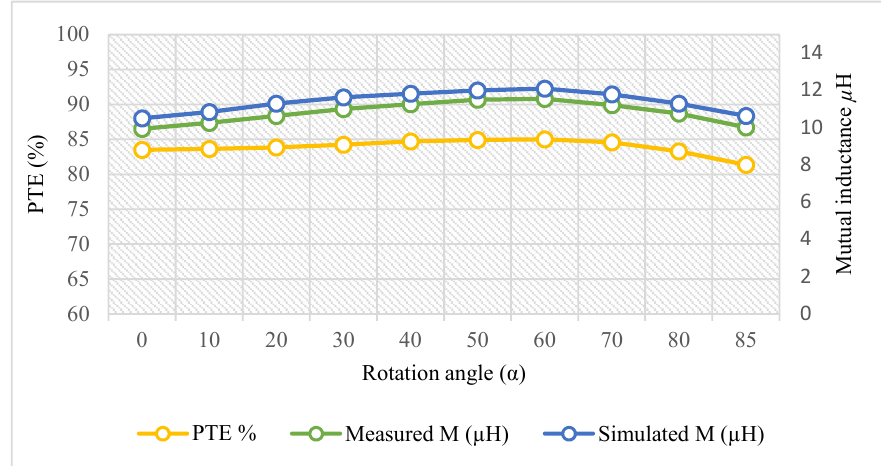
ffi ciency according to rotation